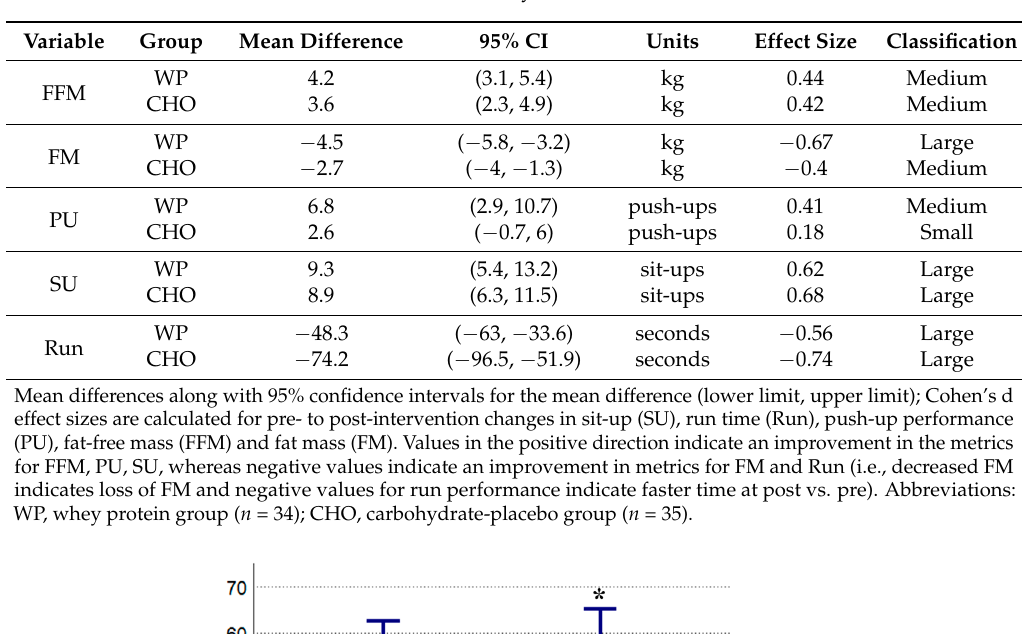
Table 2. Summary of body composition during IET.